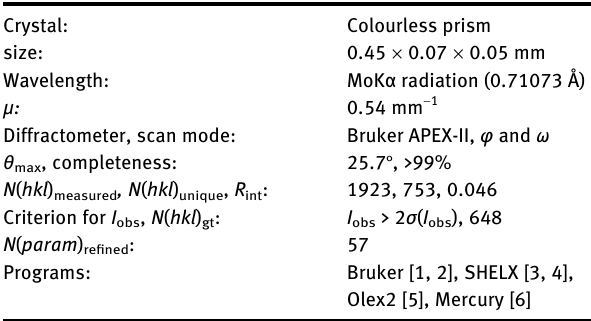
Table  : Data collection and